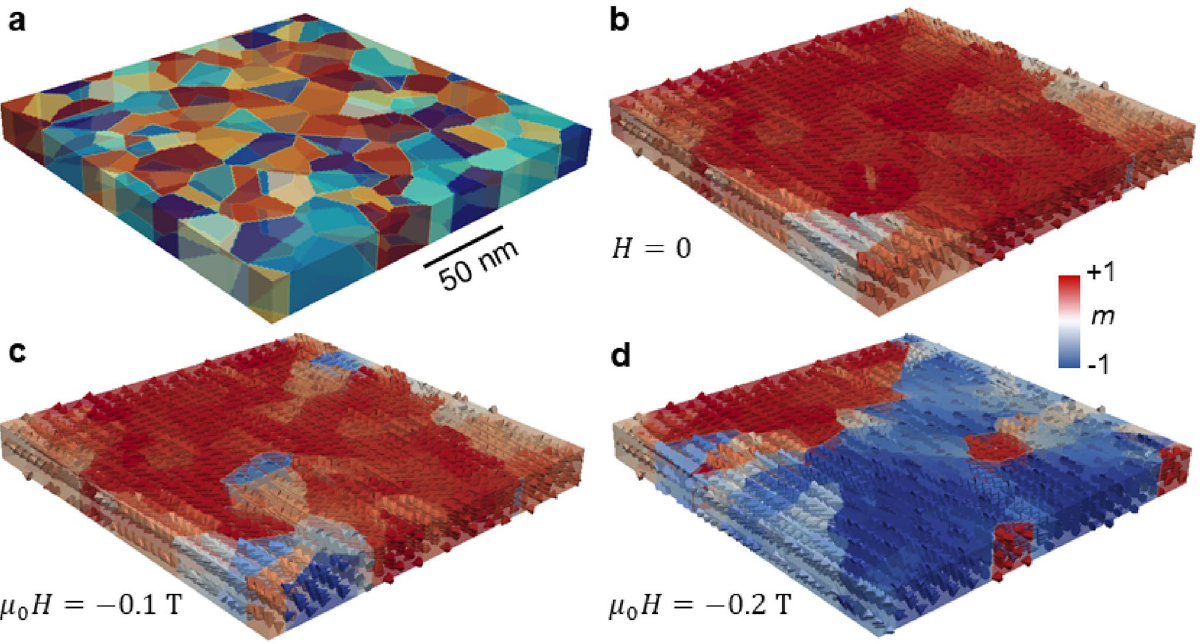
Figure 8. Micromagnetic simulations of a greigite flake. ( a ) exhibits the simulated system that mimics a greigite flake with dimensions of 200 nm × 200 nm × 20 nm consisting of intergrown crystallites with a size of about 20 nm and the colours mirror the different anisotropy vectors. ( b ) Starting from remanence after saturation, ( c , d ) the application of an external field generates a CMV